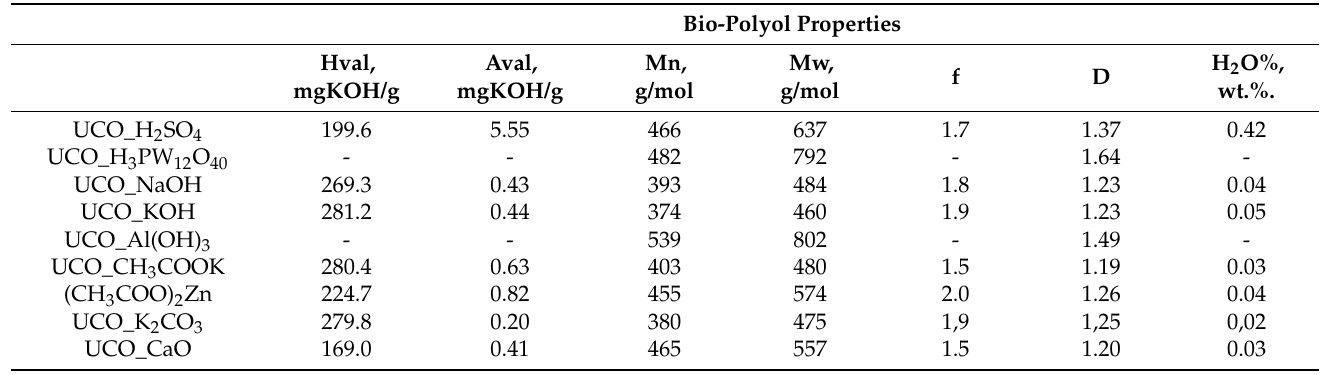
Table 3. Properties of bio-polyols obtained via reactions with various catalysts. Bio-Polyol